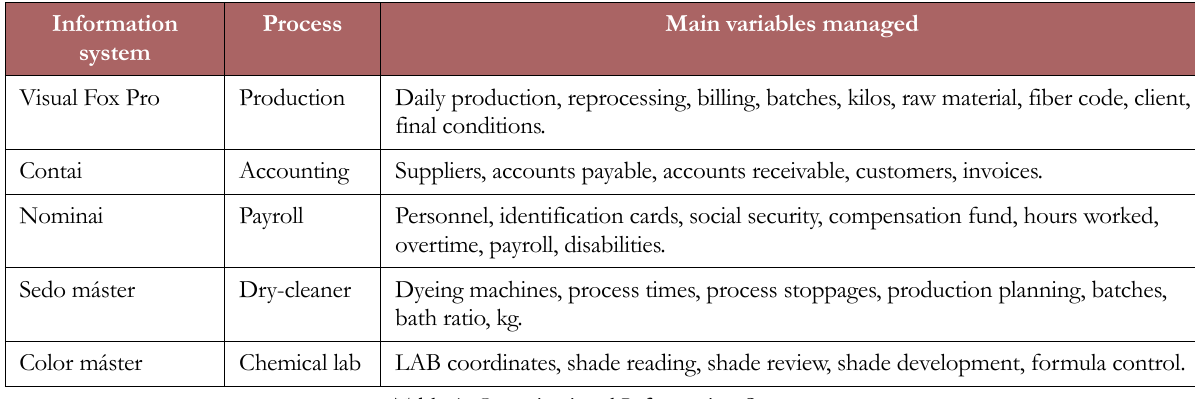
Table 1. Organizational Information